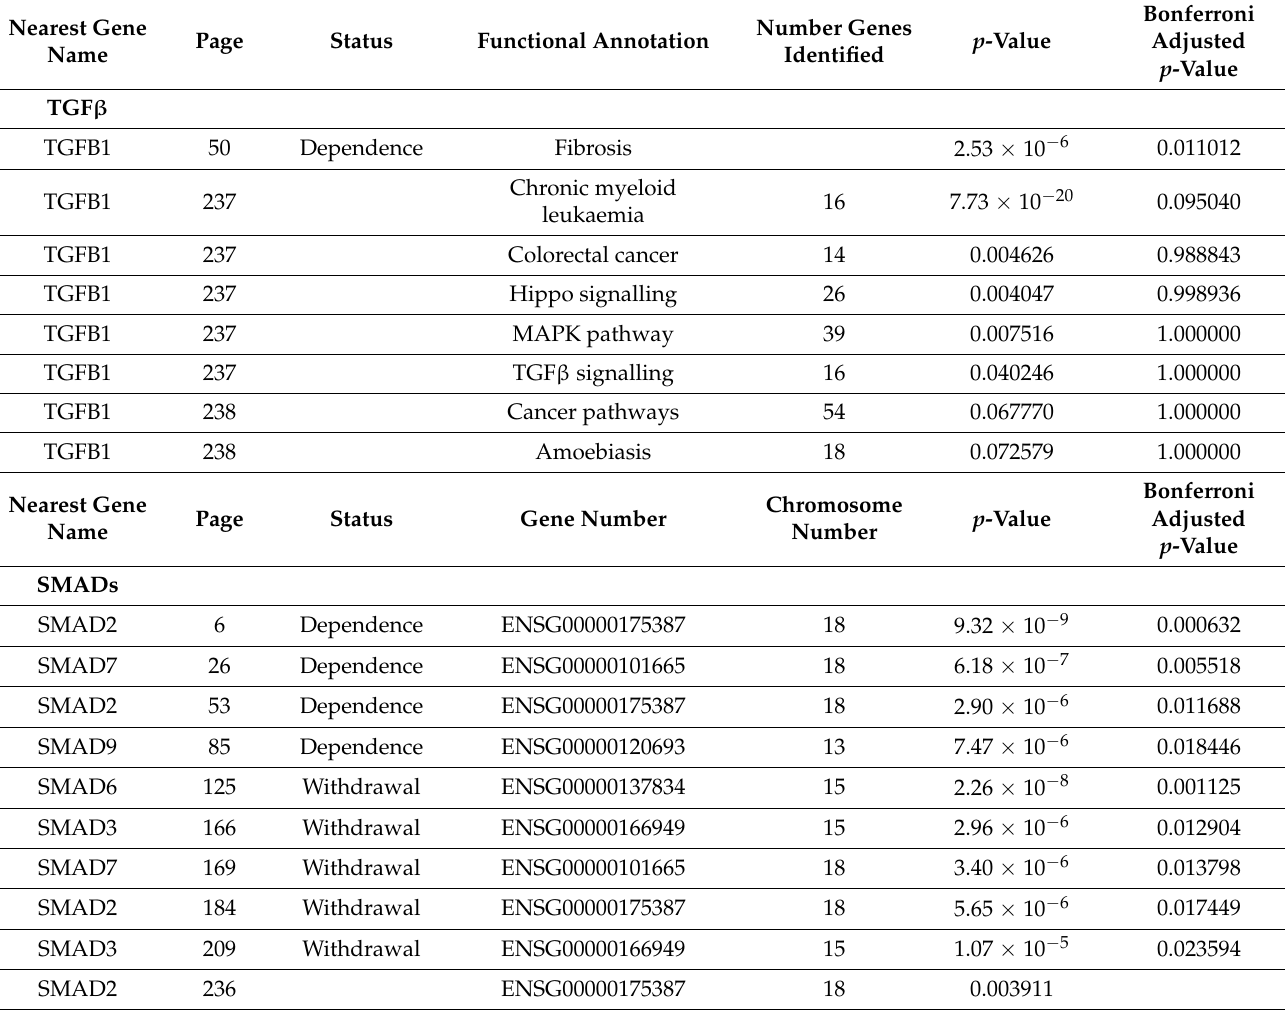
Table 22. EWAS Hits from Schrott Dataset for Significantly Differentially Methylated Regions. For TGF β